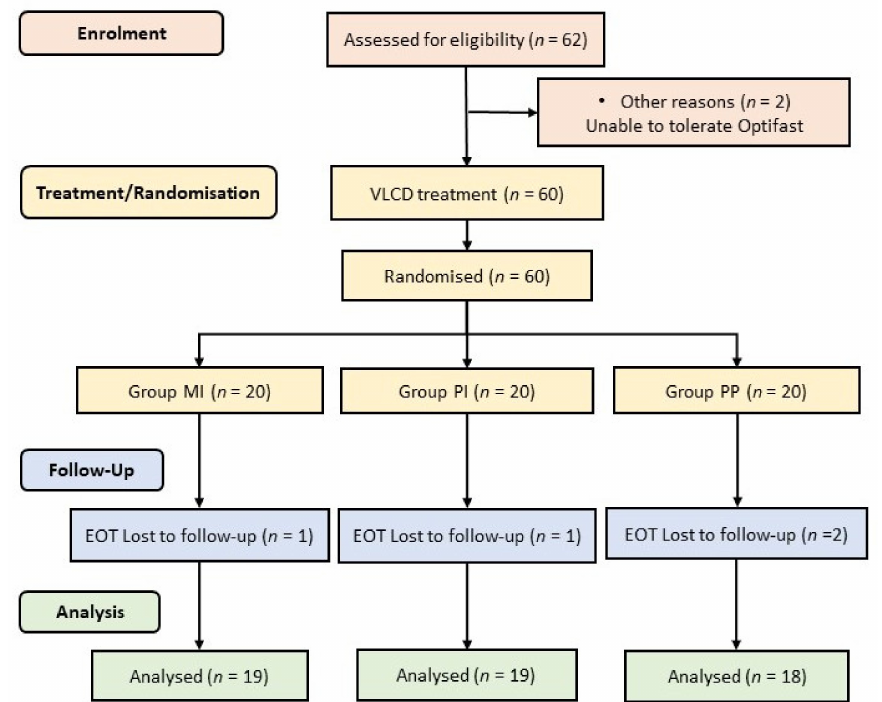
Figure A1. Flow diagram showing di ff erent phases of the study and number of participants at each stage. EOT: end of treatment; MI: metronidazole-inulin; PI: placebo-inulin; PP: placebo-placebo.